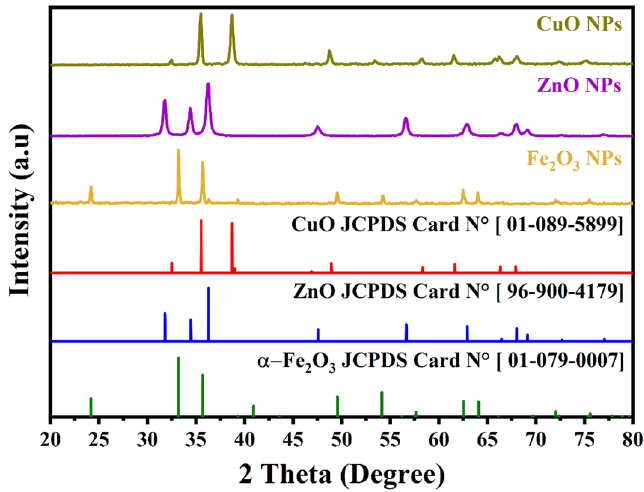
Figure 1. X-ray diffraction patterns of the α-Fe 2 O 3 , CuO and ZnO nanoparticles.